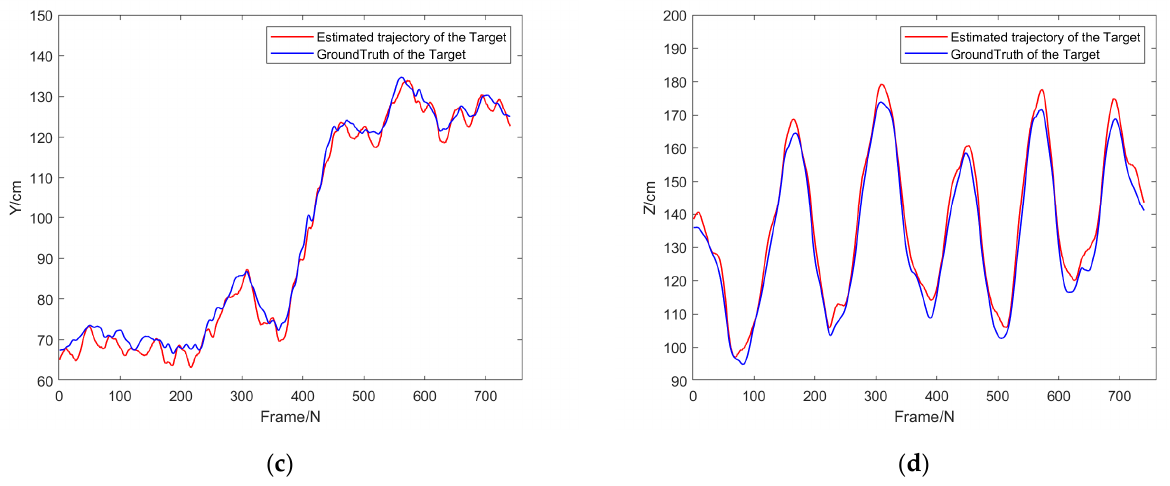
Figure 15. ( a ) Target tracking results of experiment 3: Comparison of motion trajectories under different depth values, ( b ) trajectory comparison in x-axis, ( c ) trajectory comparison in y trajectory comparison in x axis, ( d ) trajectory comparison in z-axis.